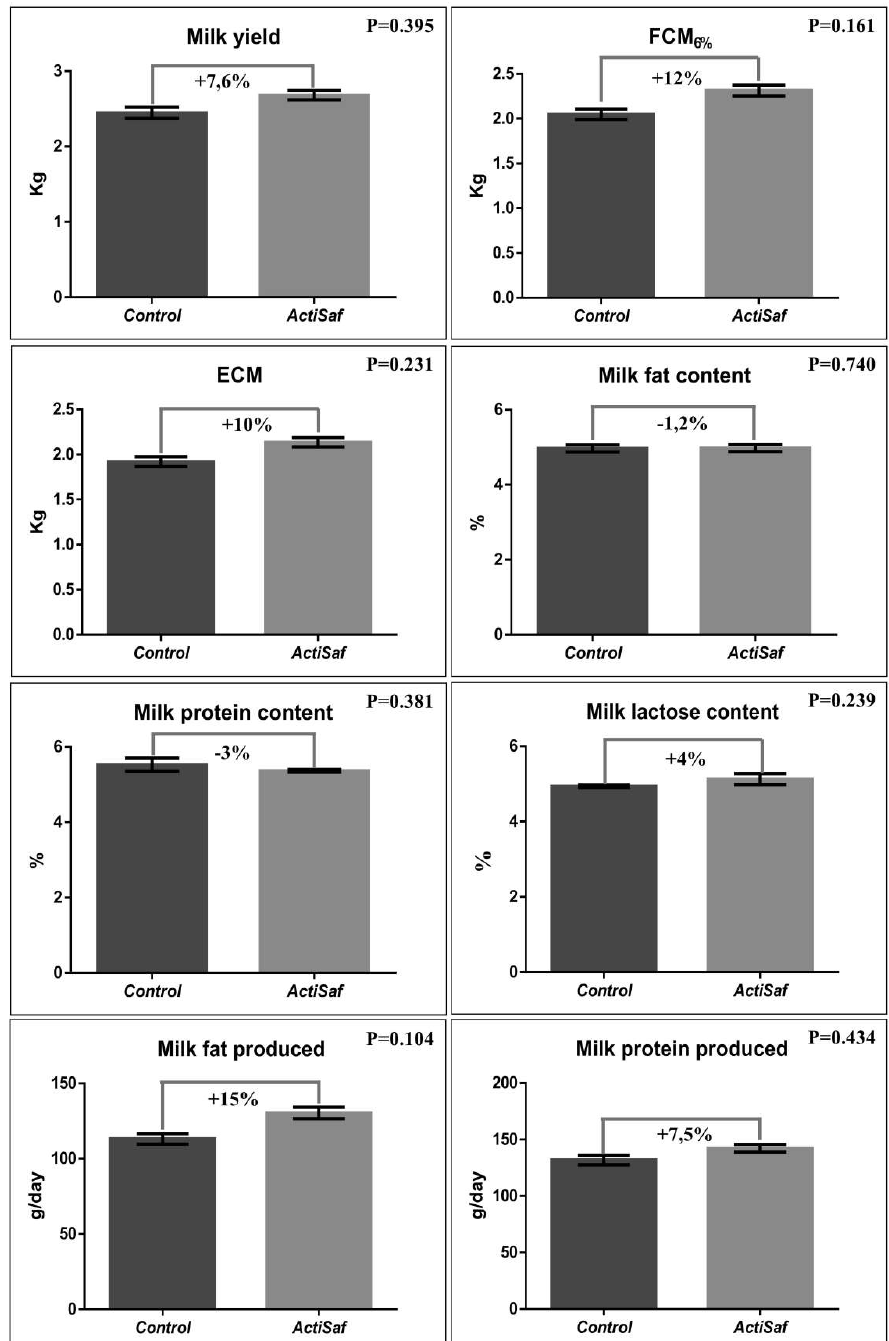
Figure 3. Graphical representation of milk yield and chemical composition of ewes in Control (black, n = 51 ewes) and ActiSaf (grey, n = 53 ewes) groups (mean ± SEM). FCM: Fat corrected milk in 6% according to the equation Y6% = (0.28 + 0.12F) M, where F = fat% and M = milk yield in kg. ECM: Energy corrected milk = milk yield × (0.071 × fat (%) + 0.043 × protein (%) + 0.2224)